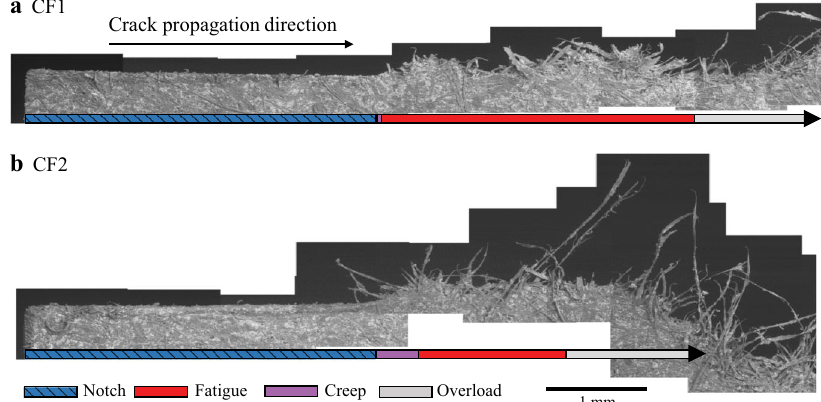
Fig. 8 Creep – fatigue loading crack pro fi les. Scanning electron microscopy was used to image the specimens ( a CF1 and b CF2) subjected to creep followed by fatigue to failure. The cracks grew across the specimen from the cut notch tip as indicated in the fi gure. The fatigue and creep portions of the fracture surface show less fi ber pullout than the overload sections (full specimen width is not shown). Digital image correlation was used to determine the crack length associated with creep, fatigue, and